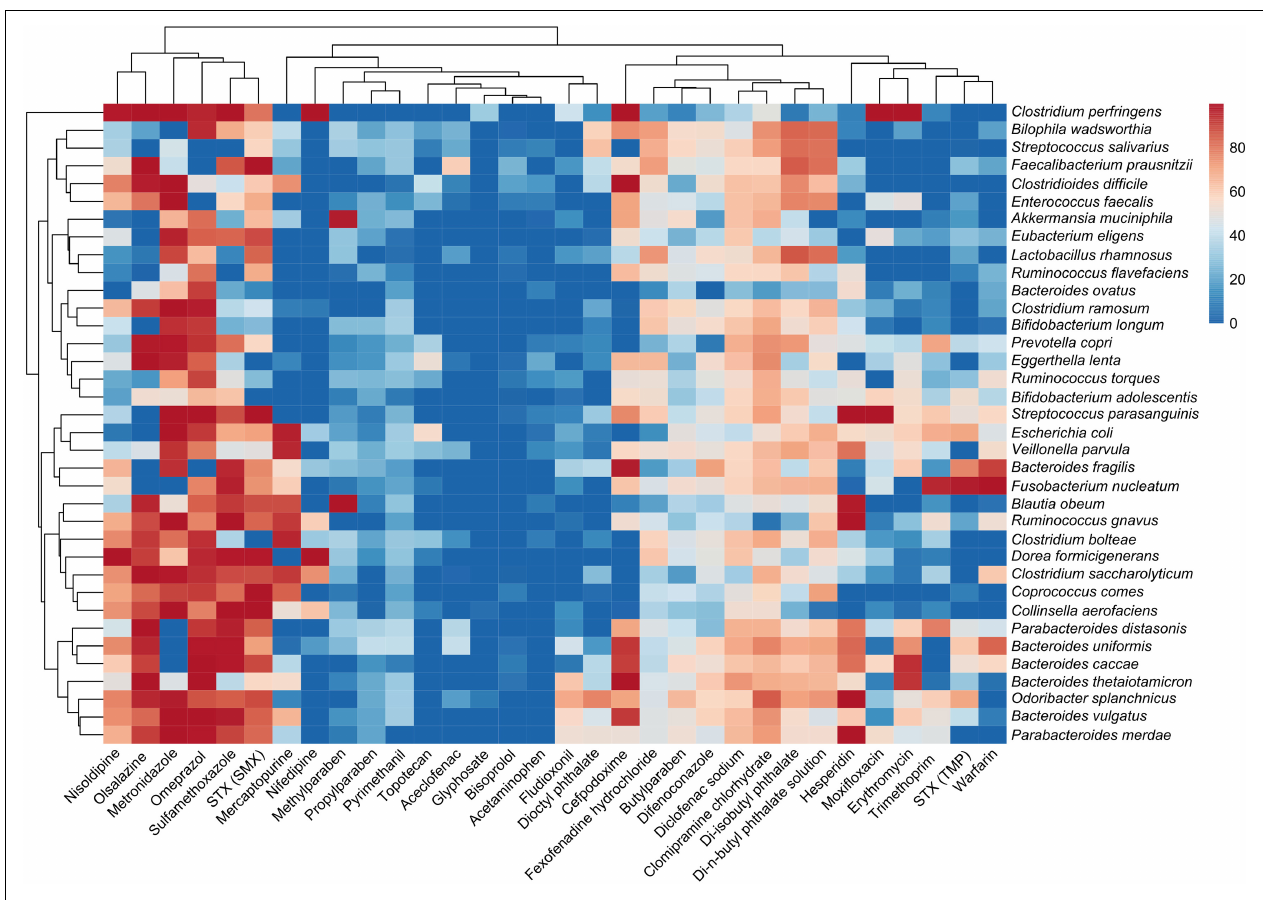
FIGURE 7 | Analysis of the native antibiotics, drugs or xenobiotics for each strain constructing the HGMM. Heatmap highlighting the absence of the native molecules in the culture supernatants of each strain separately (exception with C. leptum , R. intestinalis, and R. bromii ) using UHPLC-MS/MS analysis. Percentages of the absence of the native antibiotics, drugs or xenobiotics in the culture supernatant for each strain was calculated from the respective control cultures without bacteria. The color code indicates the absence of the molecule in the culture supernatant ranging from blue (total presence) to red (total absence). The clusterization of strains (on the left) was based on the absence of the different native molecules in the culture supernatant (not on a taxonomic relationship). The clusterization of the molecules (on the top) was based on their absence in the supernatant of each strain. Method failed with amoxicillin, ascorbic acid, bisphenol A and irinotecan. Boscalid was not tested on individual strains. STX (SMT) and STX (TMP) indicate that only sulfamethoxazole (SMT) or trimethoprim (TMP) was analyzed,